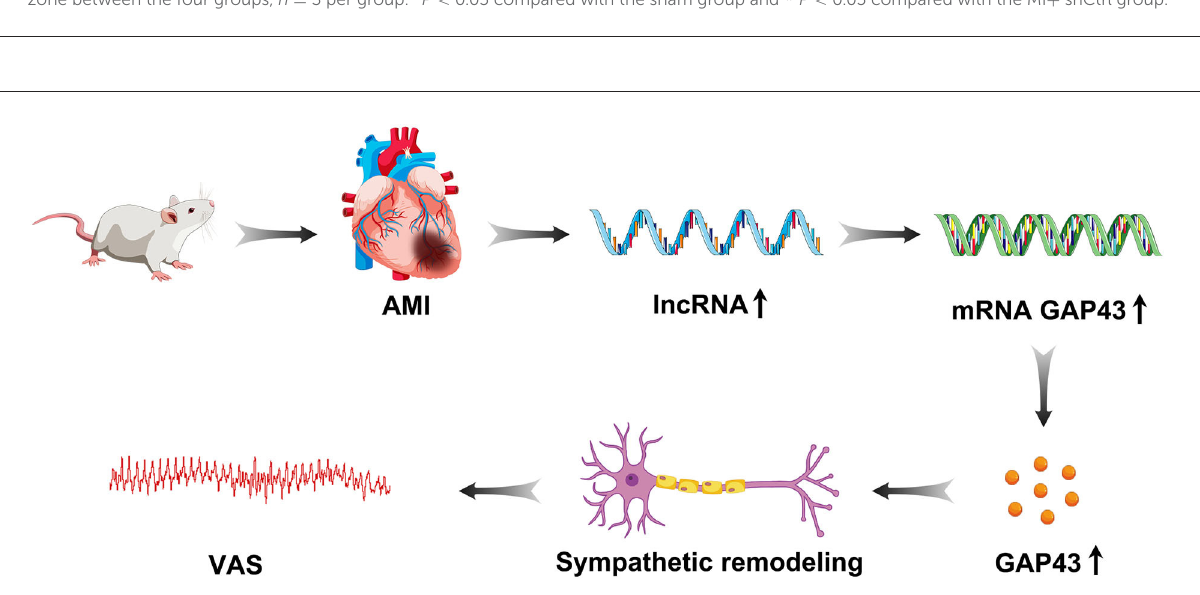
FIGURE8 Graphical representation of lncRNA LOC100911717 functions in sympathetic remodeling after